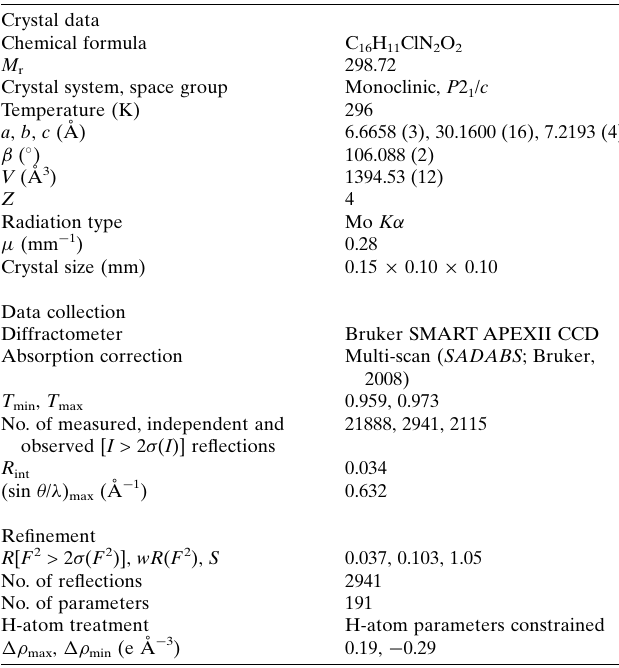
Table 2 Experimental